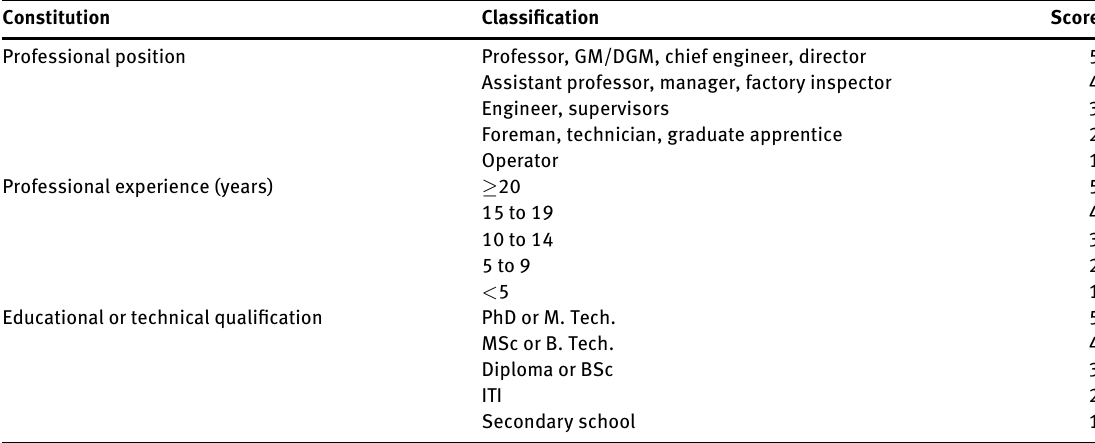
Table 4: Weighting scores for different experts